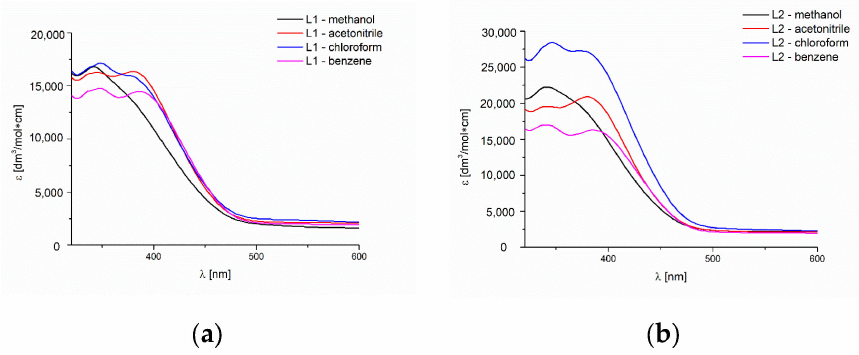
Figure 6. Solution absorption spectra of ( a ) L1 ( b ) L2 in chloroform, acetonitrile, benzene (1.7 × 10 − 5 mol/dm 3 , RT) and methanol (2 × 10 − 5 mol/dm 3 , RT) for L1 , (1,4 × 10 − 5 mol/dm 3 , RT) for L2 .